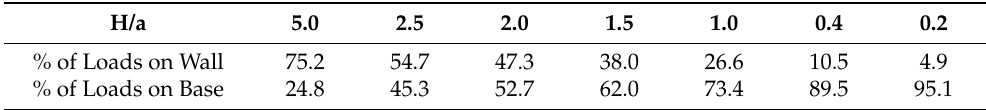
Table 5. Percentage of load distribution on walls and base with different slenderness ratios in flexible wall case.